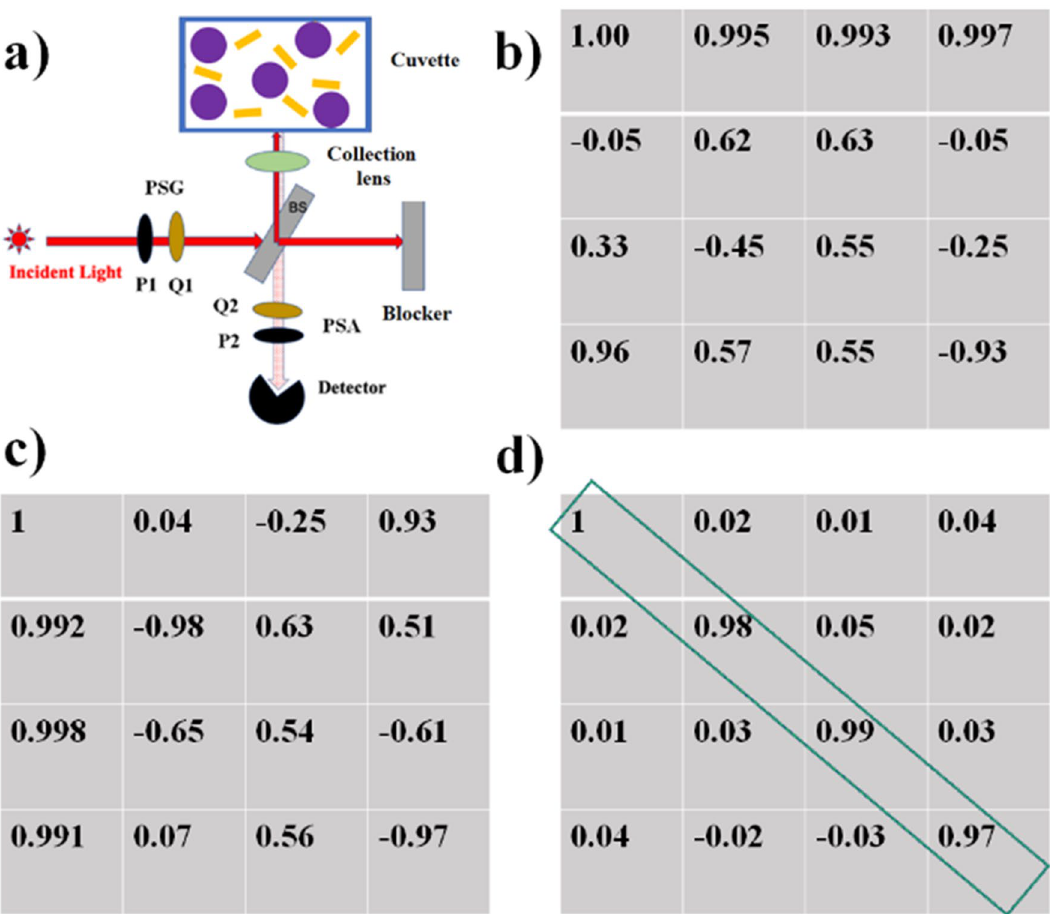
Figure 1. Experimental polarimetry set up and system calibration for exact backscattering configuration. ( a ) Schematic diagram of the experimental polarimetry system for measurements in exact backscattering configuration, comprised of an excitation laser (λ = 633 nm), a polarization state generator unit (PSG: rotating linear polarizer P1 and quarter wave plate Q1), a polarization state analyzer unit (PSA: rotating quarter wave plate Q2 and linear polarizer P2), beam splitter (BS), collection lenses and a photodetector. Actual experimental form of the ( b ) PSG matrix W and ( c ) PSA matrix A. ( d ) The experimental Mueller matrix from a cuvette filled with distilled water resembles an identity matrix as expected, with individual elements exhibiting an error 0.05 ≤